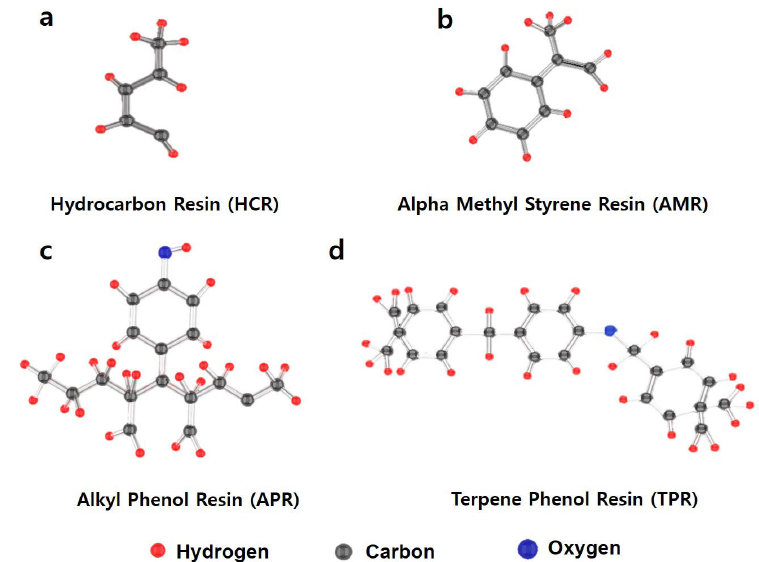
Figure 1. Molecular structure diagram of ( a ) hydrocarbon resin, ( b ) alpha methyl styrene resin, ( c ) alkyl phenol resin, and ( d ) terpene phenol resin.